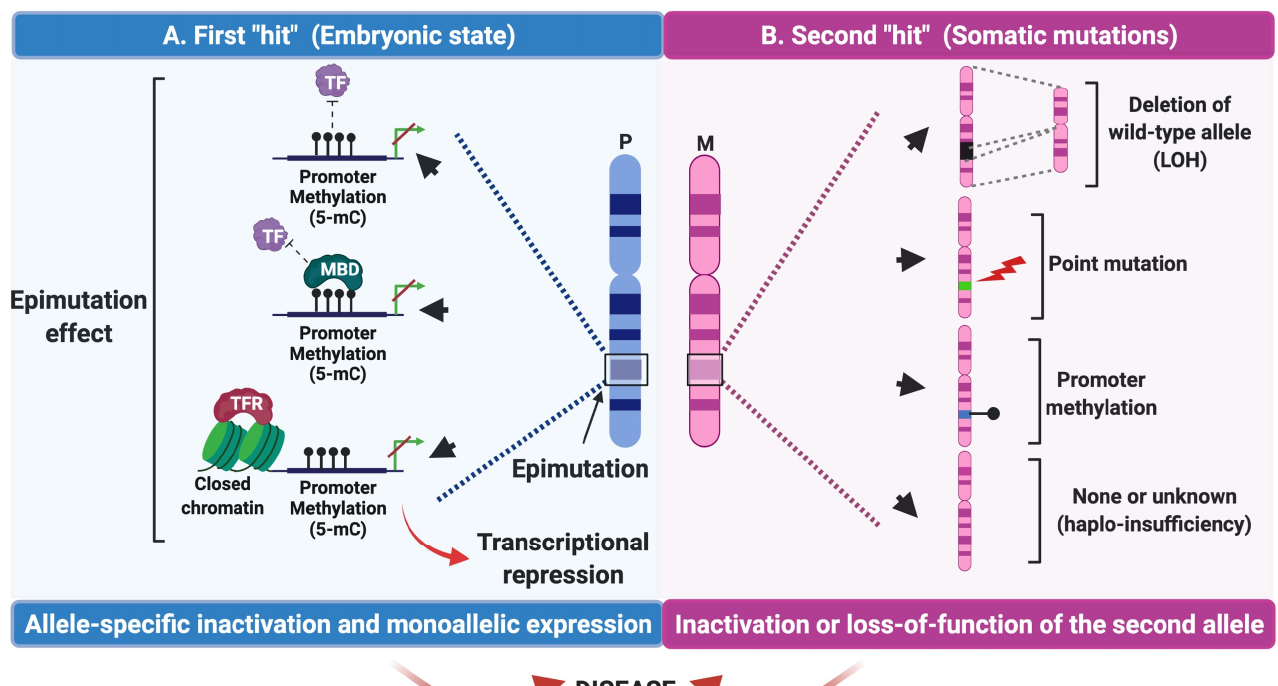
Figure 3. Knudson’s “two-hit hypothesis” on epimutations and cancer. ( A ) The first hit is promoted by epimutations in the promoter region in germ cells. This prevents the binding of TFs to DNA (top). Another mechanism dependent on MBD can be recruited into methylated DNA and compete directly with TFs through their greater affinity for the 5-mC site to the DNA sequence (middle part), or that act synergistically with TFRs to transcriptionally repress a gene. In all cases, this first hit induces the inactivation of the mono-allelic expression of a gene. ( B ) The second hit is driven by somatic cell mutations such as deletions (LOH), point mutations, other allelic epimutations, or by haploinsufficiency mechanisms that trigger the loss-of-function of the second allele (biallelic inactivation) and induce tumorigenesis. P: Paternal, M: Maternal, TF: Transcription Factor, TFR: Transcription Factor Repressor, MBD: Methyl-CpG-binding domain (MBD), 5-mC: 5-Methylcytosine, LOH: Loss of Heterozygosity.